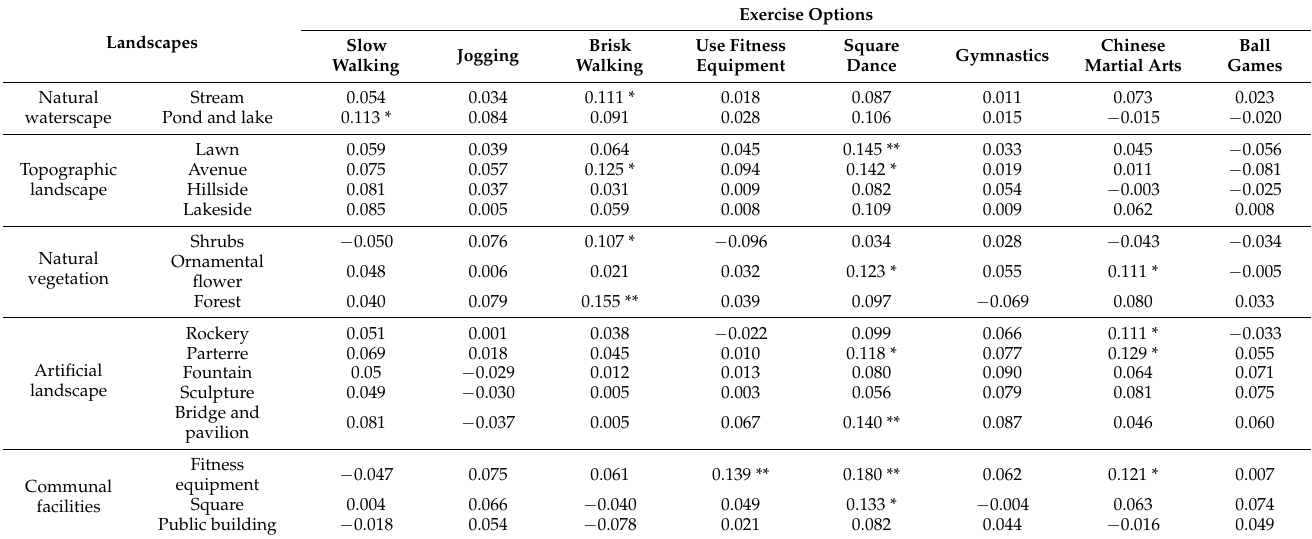
Table 4. Correlation between different exercise forms and visual landscape preferences.